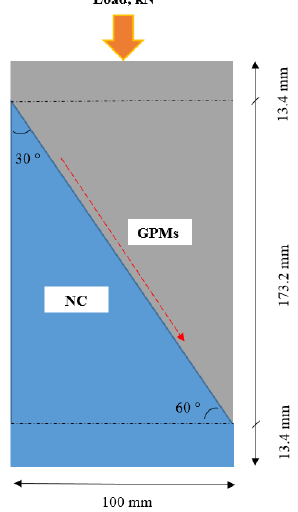
Figure 16. Geometry of SSBS test.